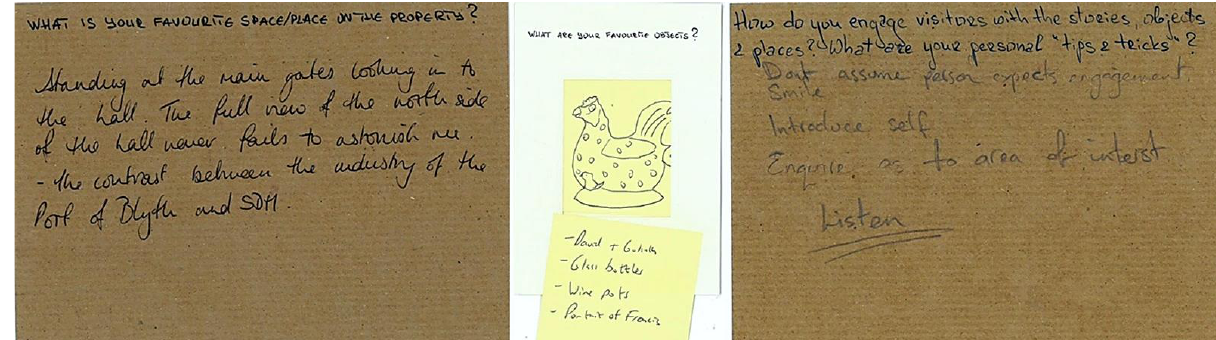
Figure 1. Three filled-in probes capturing favourite places and objects and tips to engage